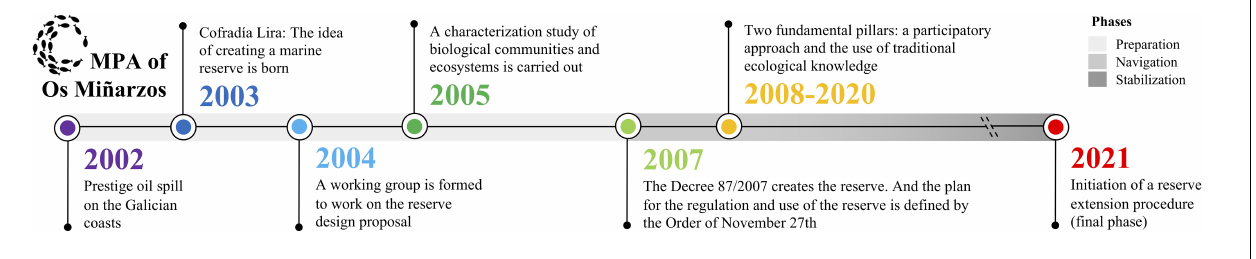
Frontiers in Marine Science |